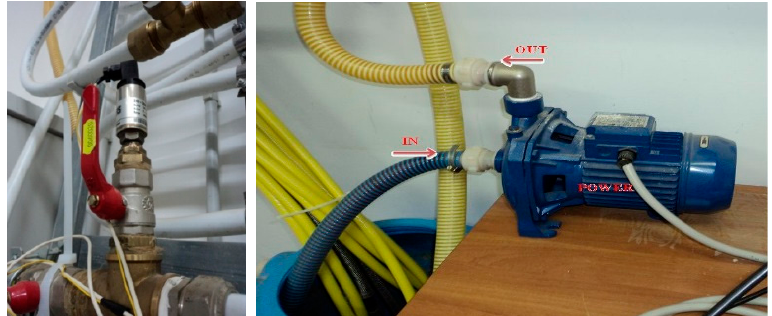
Figure 5. Sensor mounted on pipeline and pump for extracting and launching water in the pipeline. A Gems sensor was used.